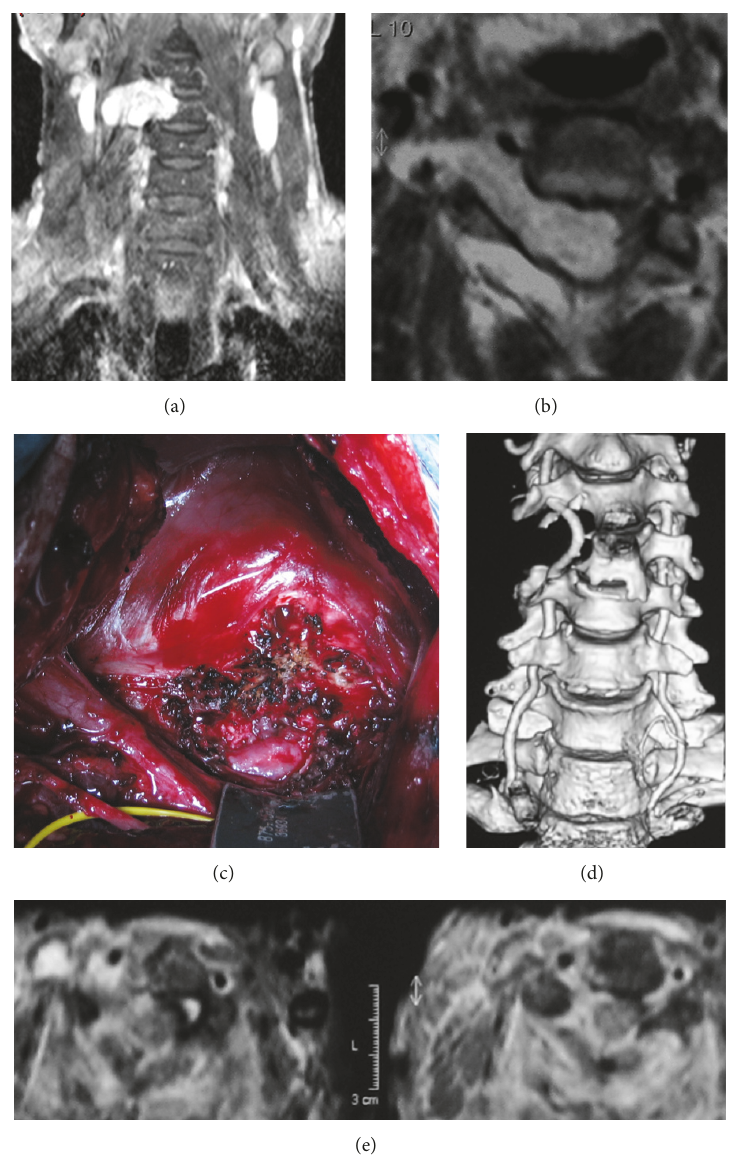
Figure 1: Illustrative case. A 58-year-old man presenting with right arm weakness, paraparesis, and increased reflexes: (a) T1w MRI with contrast, coronal view showing dumbbell schwannoma at C3-C4 level with bone erosion of the vertebral body; (b) T1w MRI, axial section; vertebral artery was anteriorly dislocated (white arrow) and combined, two-step anterior-lateral and posterior approaches to the cervical spine were performed; (c) intraoperative view during anterior-lateral approach; (d) postoperative CT scan showing surgical excision of the tumor with preservation of the vertebral artery; (e) T2w postoperative MRI, axial